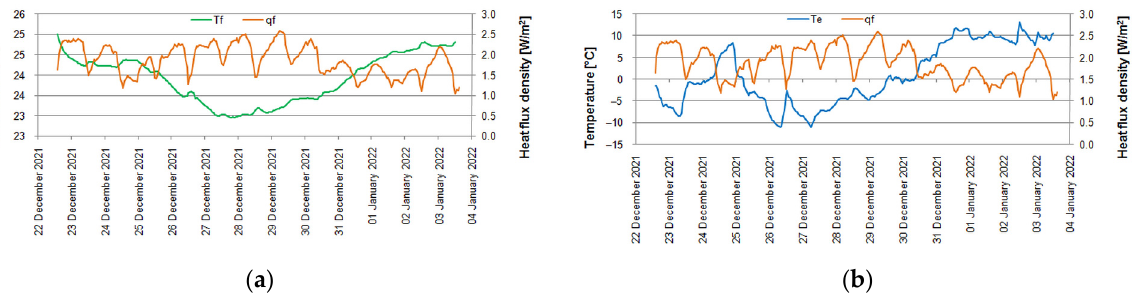
Figure 6. Measurement results: ( a ) Floor temperature and floor heat flux density; ( b ) Outdoor air temperature and floor heat flux density.